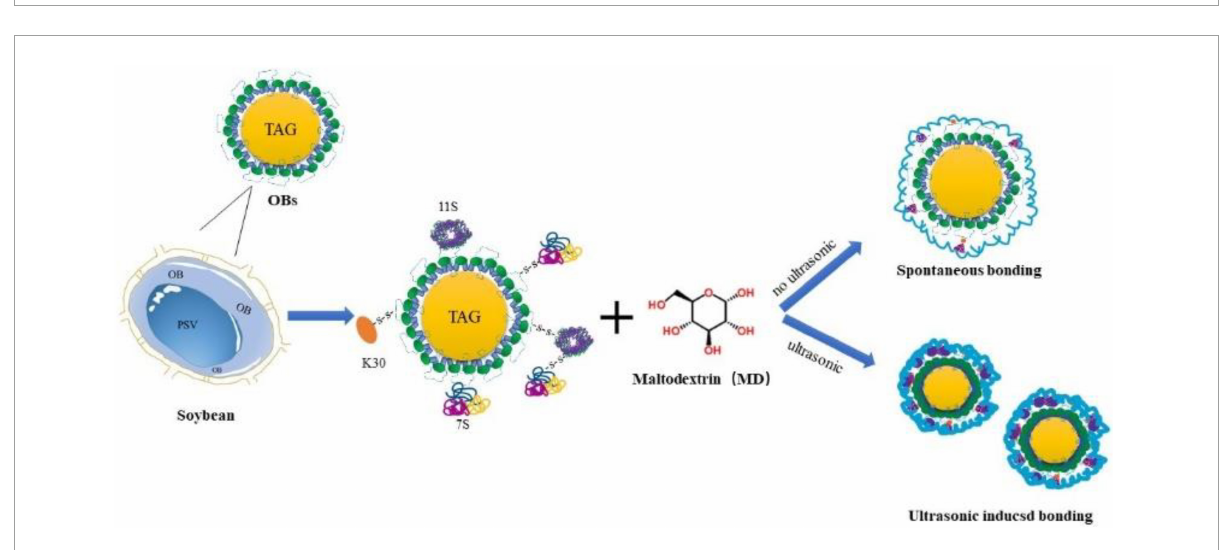
OB-MD 1.5 had a better oxidative stability. The oxidative stability of the OB-MD prepared by 250 W sonication was better than that of the non-sonicated microcapsules. Thus, when